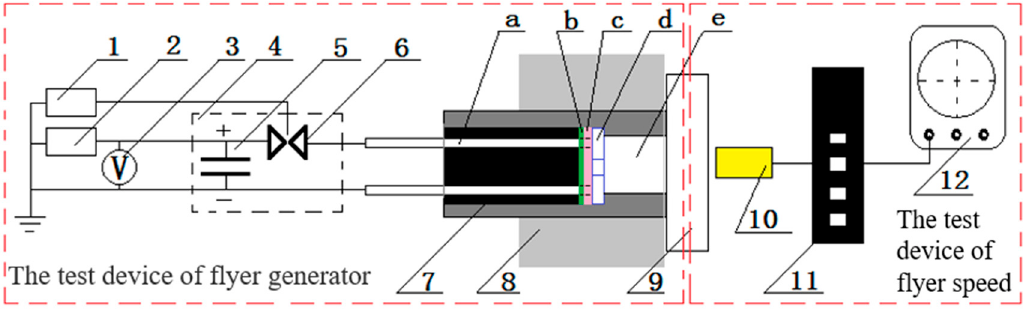
Figure 1. Schematic diagram of the flyer velocity measuring test system.